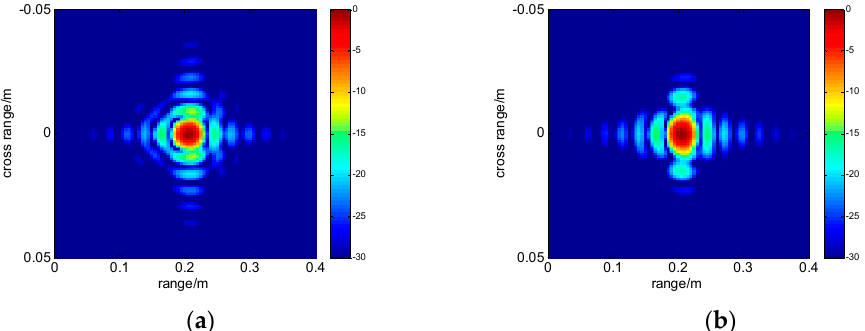
Figure 5. Simulated PSF in two different cases, ( a ) is the PSF when the signal leakages do not exist and ( b ) is the PSF when leakages exist.